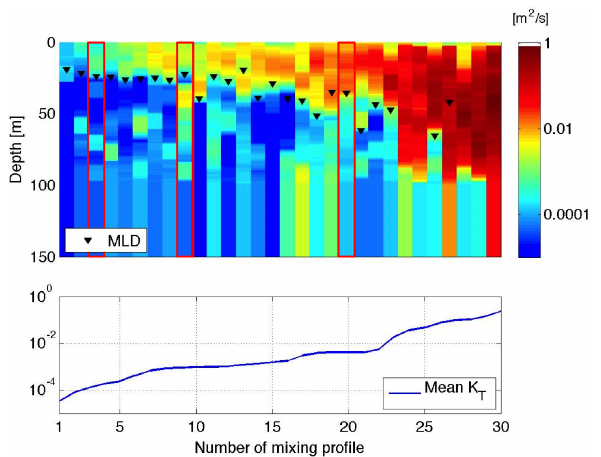
Fig. 10: Phytoplankton concentration results of the sensitiv- ity study based on the vertical mixing shown in Fig 9 and the three reference stations: southern, transition and northern (top to bottom). The red boxes show the according reference state.